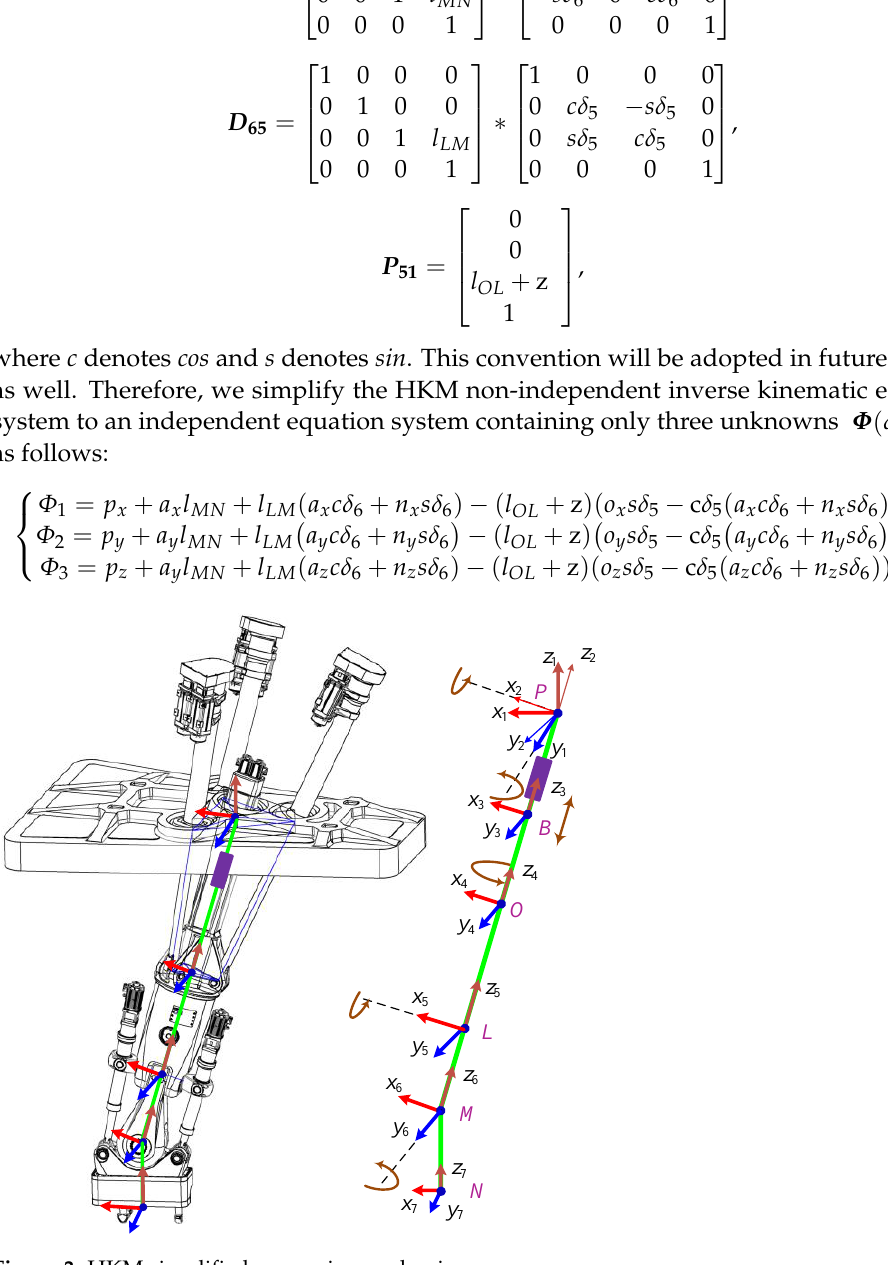
Figure 3. HKM simplified as a series mechanism.